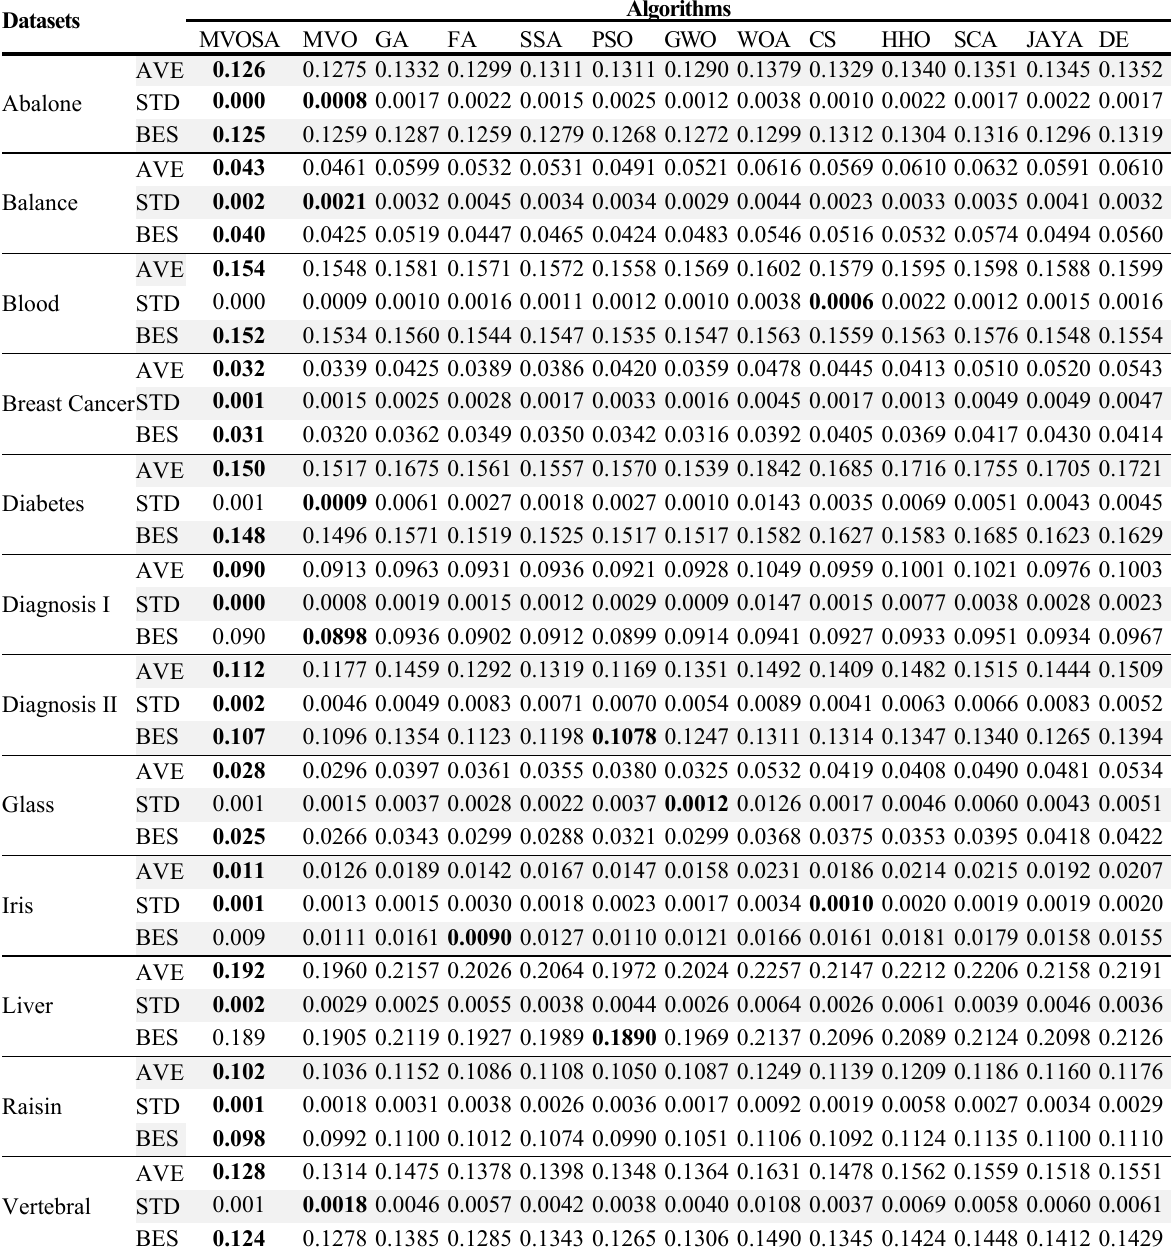
Table 5 Results of MSE for all datasets and algorithms